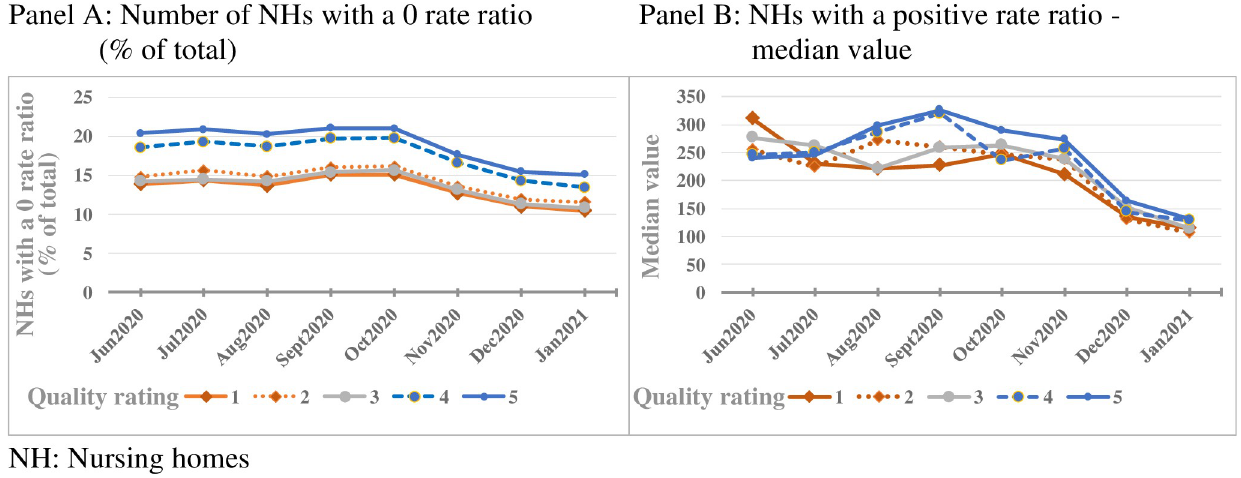
Fig 1. Differences in mortality outcomes by nursing home quality ratings, June 2020—January 2021.